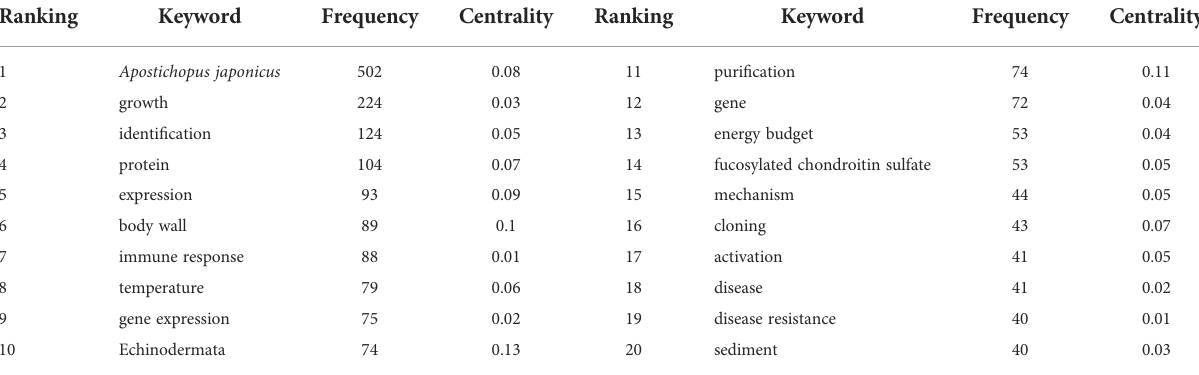
TABLE 6 The 20 most frequently used keywords in articles related to Apostichopus japonicus research published from 2000 to 2021. Ranking